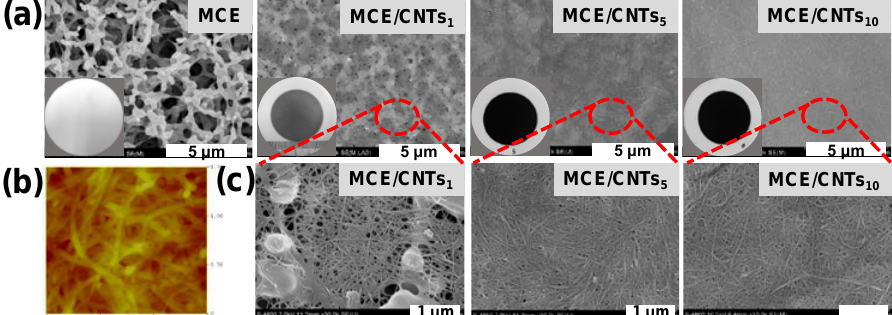
Figure 3. Surface morphology of MCE / CNTs support layer. ( a ) surface SEM images with insets of digital photos, ( b ) surface AFM morphology of MCE / CNTs 10 support layer and ( c ) magnified surface SEM images.